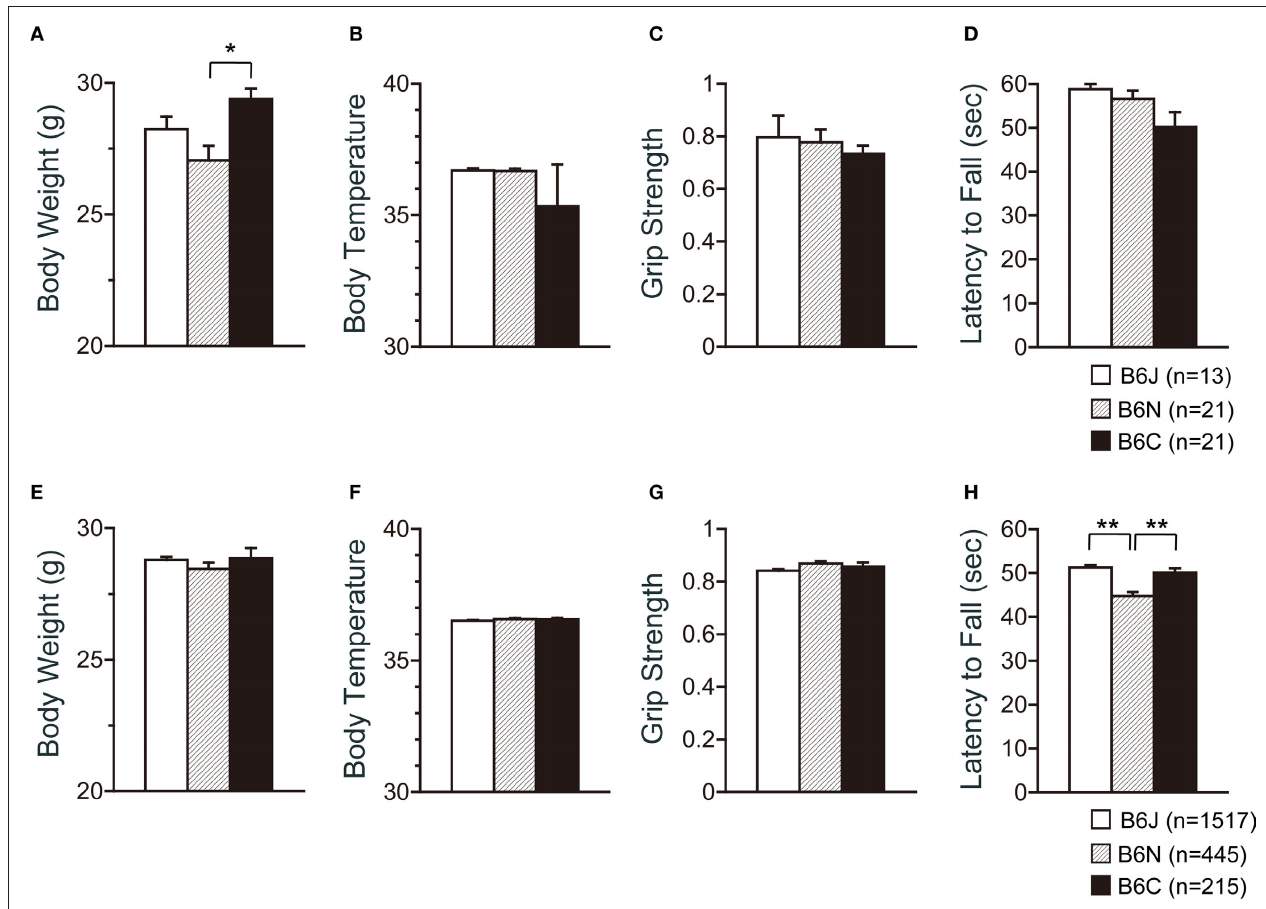
Figure 1 | Physical characteristics of C57BL/6 substrains. (A–D) Regular scale analysis. (e–H) Large-scale analysis. (A,e) Body weight. (B,F) Body temperature. (C,g) Grip strength test. (D,H) Wire hang test. * p < 0.001, ** p < 0.0001. Error bars indicate